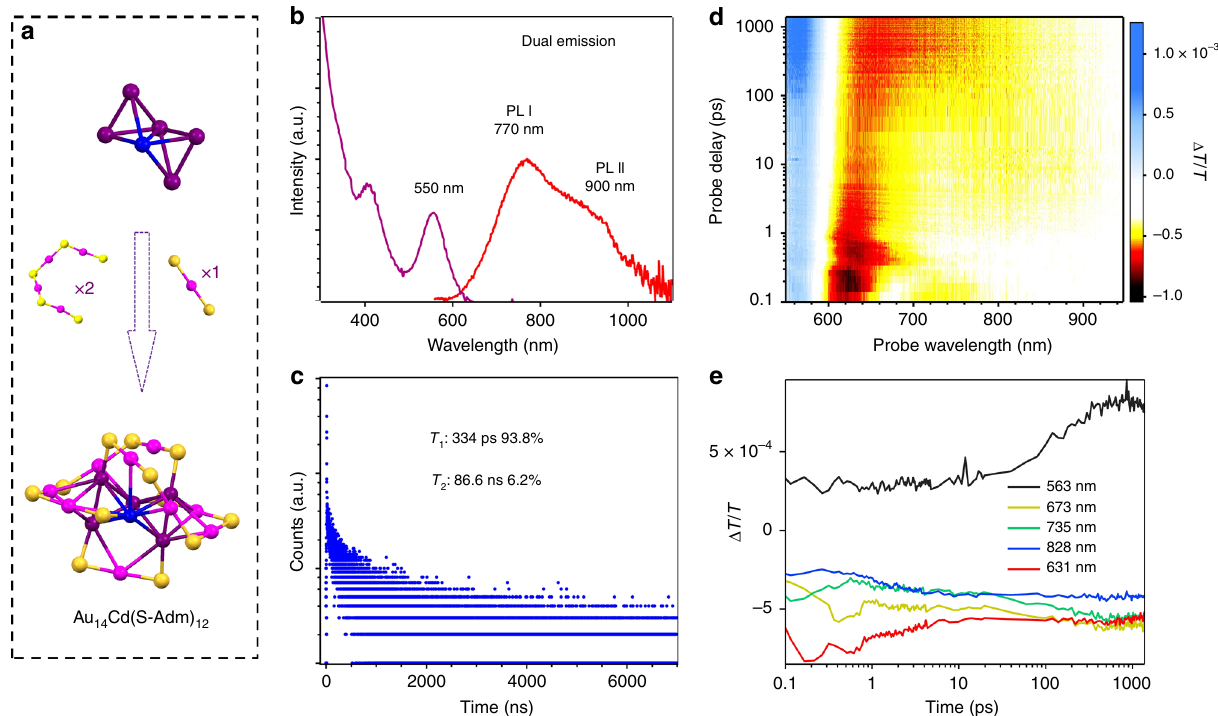
Fig. 6 Optical properties and excited-state dynamics of Au 14 Cd. a Anatomy of the atomic structure of Au 14 Cd 31 . Purple = core Au; magenta = surface Au; blue = Cd; yellow = S; Carbon tails are omitted for clarity. ( b ) UV-Vis absorption (purple) and PL (red) spectra. PL photoluminescence. c TCSPC trajectory, which is detected at 850 nm. τ PL lifetime component. d fs-TA spectra of Au 14 Cd pumped at 550 nm, showing the Δ T / T at all time delays between 550 and 950 nm. e Selected kinetic traces at typical